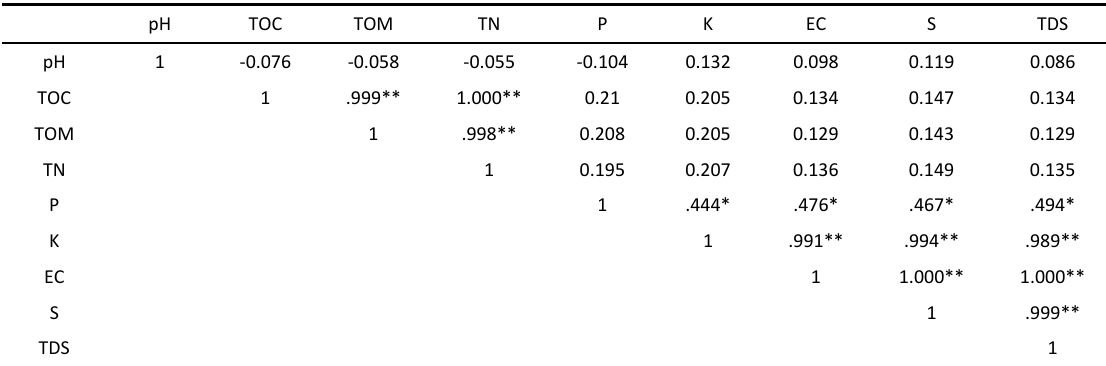
Table 3: Correlation among different variables of soil samples